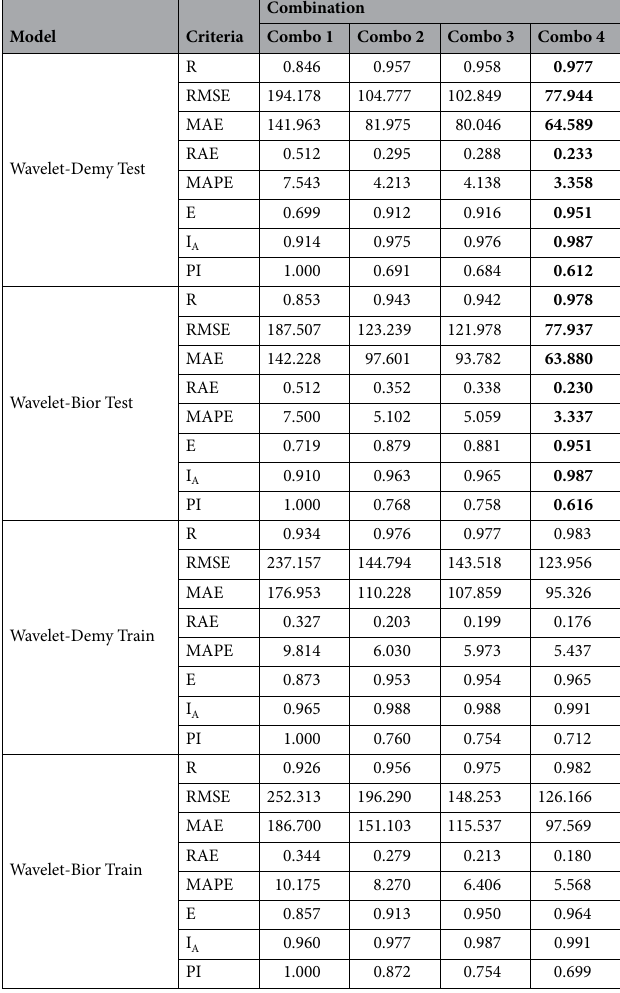
Table 10. Statistic metrics obtained by W-MARS model to forecast the EC parameter for all combinations. Significant values are in